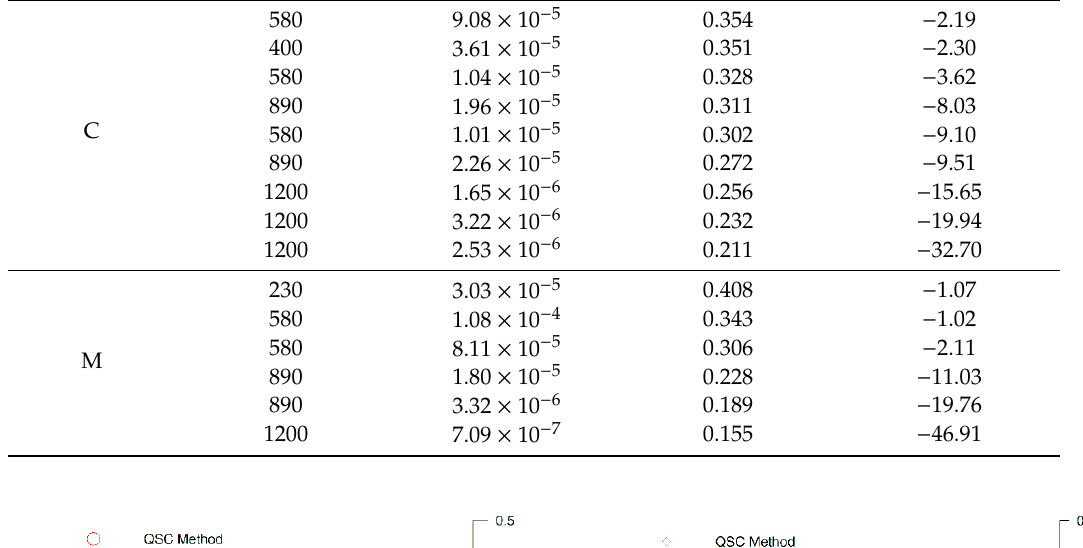
Table 4. The fitting parameters used for the curves in Figures 6 and 7. θ max is the maximum water content measured by the QSC, ψ 0 is the air-entry value, and λ is the pore distribution index, K sat is the saturated hydraulic conductivity, n is an empirical parameter, and GoF is the root mean square goodness of fit. The parameters were obtained by the KOPCEN code [63].